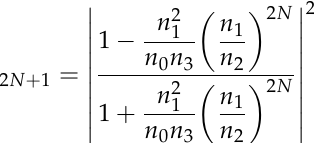
where ω LO and ω TO stand for the vertical and horizontal light phonon frequencies, with value of 972 cm − 1 and 796 cm − 1 , respectively; ε ∞ is intercalated as the high-frequency dielectric permittivity, γ is defined as the damping ratio caused by vibration and harmonic wave, and ω is the frequency of the incident light. ε ∞ is selected for 6.5, and γ is chosen to be 3.75 cm − 1